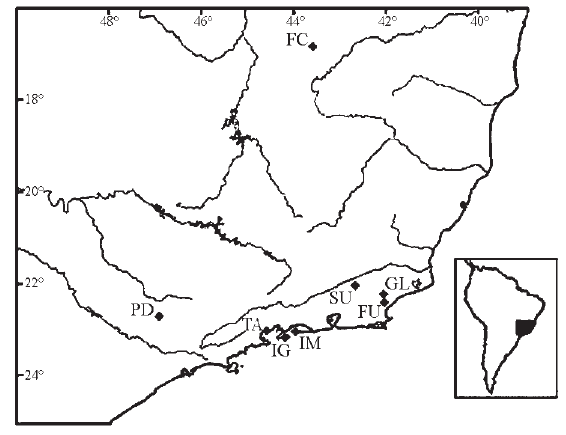
Figure 1 - Collection sites of N. squamipes in eastern